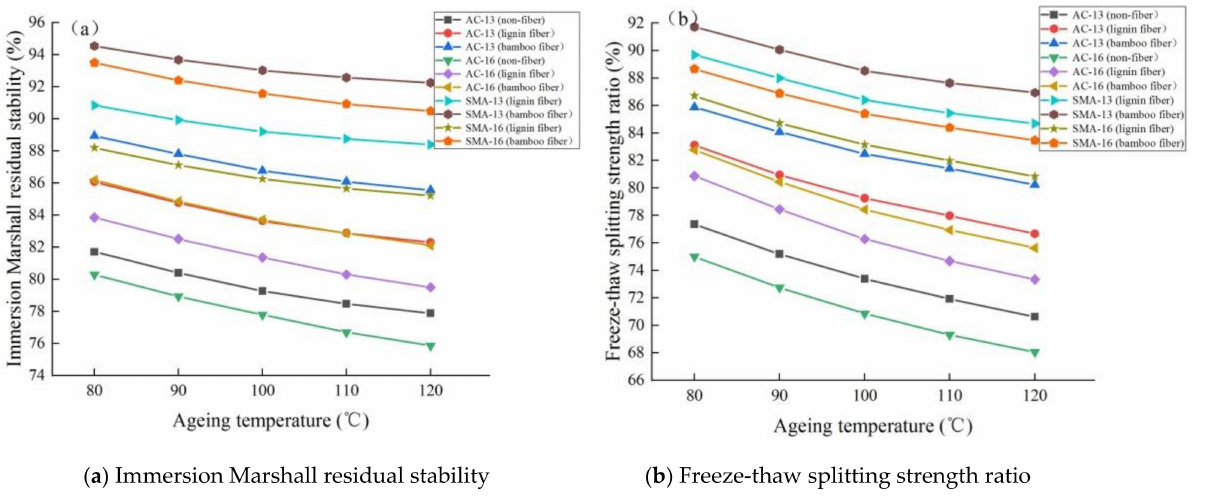
Figure 9. Results of moisture stability test of fiber asphalt mixture under different ageing temperatures. It can be seen from Figure 9